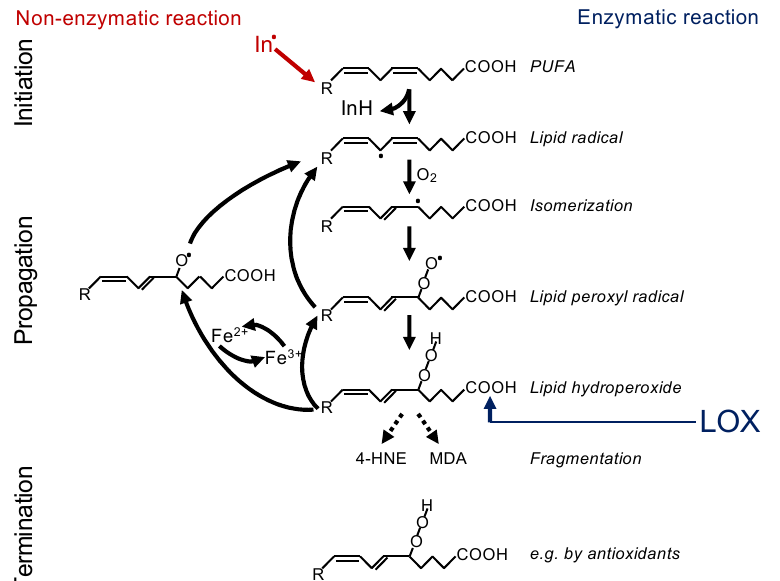
Figure 1. Mechanism of lipid peroxidation. Left: Radical initiation is carried out by a radical (initiator = In . ) abstracting a hydrogen from a bisallylic site, i.e., the carbon between two double bonds of a PUFA, thereby creating a carbon-centred lipid radical (L*). Due to the adjacent double bonds, the radical can delocalize its electron system, resulting in a resonance-stabilized conformation. In a fast reaction, oxygen is then added, and a lipid peroxyl radical (LOO*) is formed. By abstracting a hydrogen from an adjacent PUFA, the lipid peroxyl radical itself reacts to a lipid hydroperoxide (LOOH) and generates the next carbon-centred radical (L*), thereby propagating the chain reaction. The lipid hydroperoxide (LOOH) is readily decomposed, either by ferrous iron (Fe 2+ ) to the lipid alkoxyl radical (LO*) or by ferric iron (Fe 3+ ) back to the lipid peroxyl radical (LOO*). Both radicals can fuel the chain reaction. The reaction is terminated when two radicals meet each other, e.g., forming a lipid dimer (L-L) or a peroxide-bridged lipid dimer (LOOL) (not shown), or when a radical meets a radical trapping agent, for instance, coenzyme Q10 or alpha-tocopherol (vitamin E), creating a lipid hydroperoxide (LOOH). Right: Alternatively, lipid peroxidation is carried out in a controlled manner by lipoxygenases (LOX). Although initiating the process at the level of lipid hydroperoxide formation, the lipid hydroperoxide will be decomposed by ferrous or ferric iron to lipid alkoxyl and peroxyl radicals, respectively, and the vicious circle of radical formation will be fuelled as described above. Hence, the initial enzymatic reaction is switched in a second step to a radical process [29].